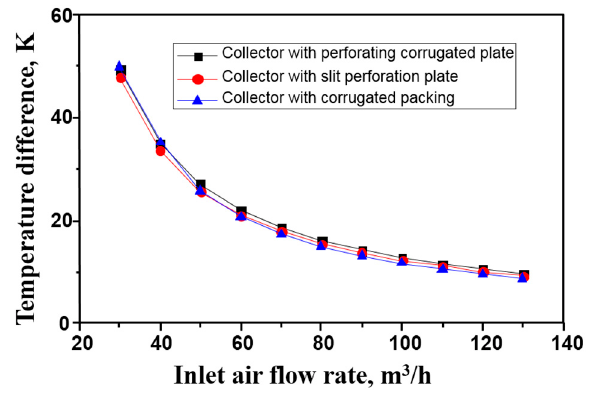
Figure 10. Effects of inlet air flow rate on the temperature difference.